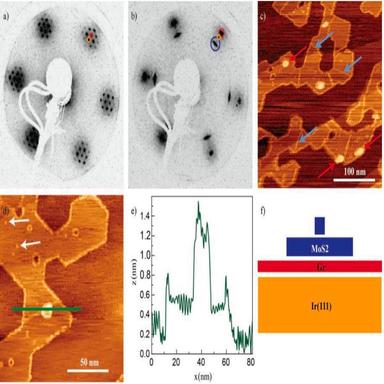
a)-b) LEED patterns of graphene/Ir(111) and MoS2/graphene/Ir(111), respectively. Diffraction spots of graphene (red), Ir (orange) and MoS2 (blue) are marked by circles. Electron energy was 73 eV in each case. c)-d) STM images of monolayer MoS2 islands. Grain boundaries (blue) and point defects (white) in monolayer MoS2, as well as bilayer islands (red), are indicated by arrows. Tunneling current, bias voltage: − 0.67nA, − 1.36 V. (e) STM line profile along the green line in d). f) Schematic sectional view a